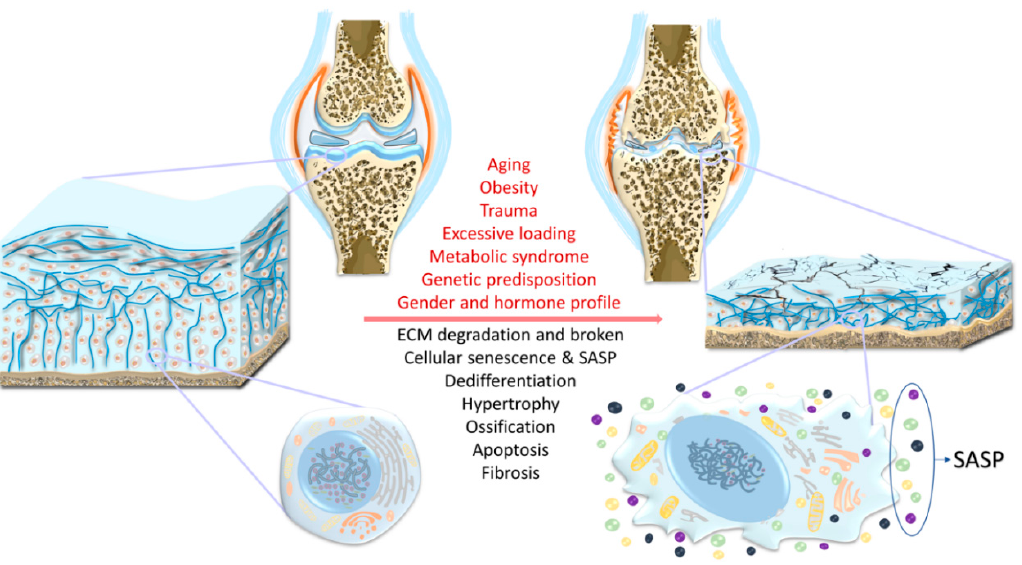
Figure 1. Risk factors, structural alterations, and chondrocyte-specific changes in osteoarthritis